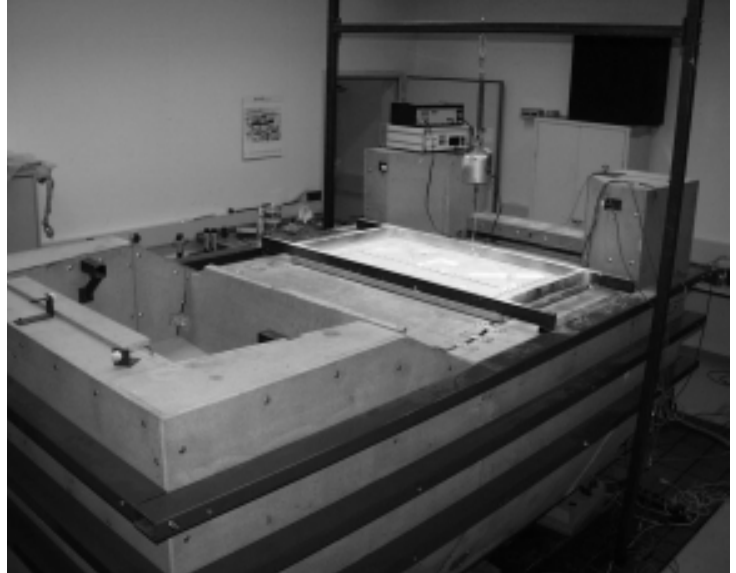
Fig. 12. Photograph of the measurement setup in the laboratory.